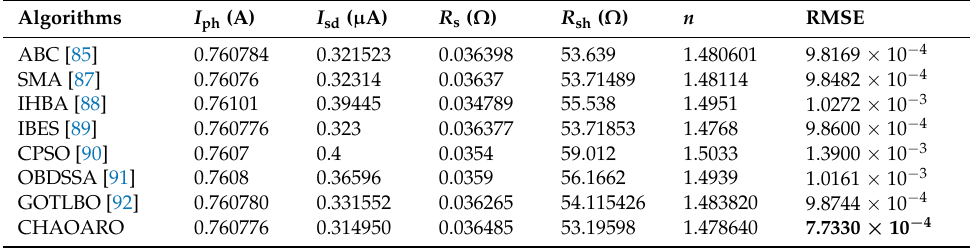
Table 17. Comparison results for the parameter identification of SDM.